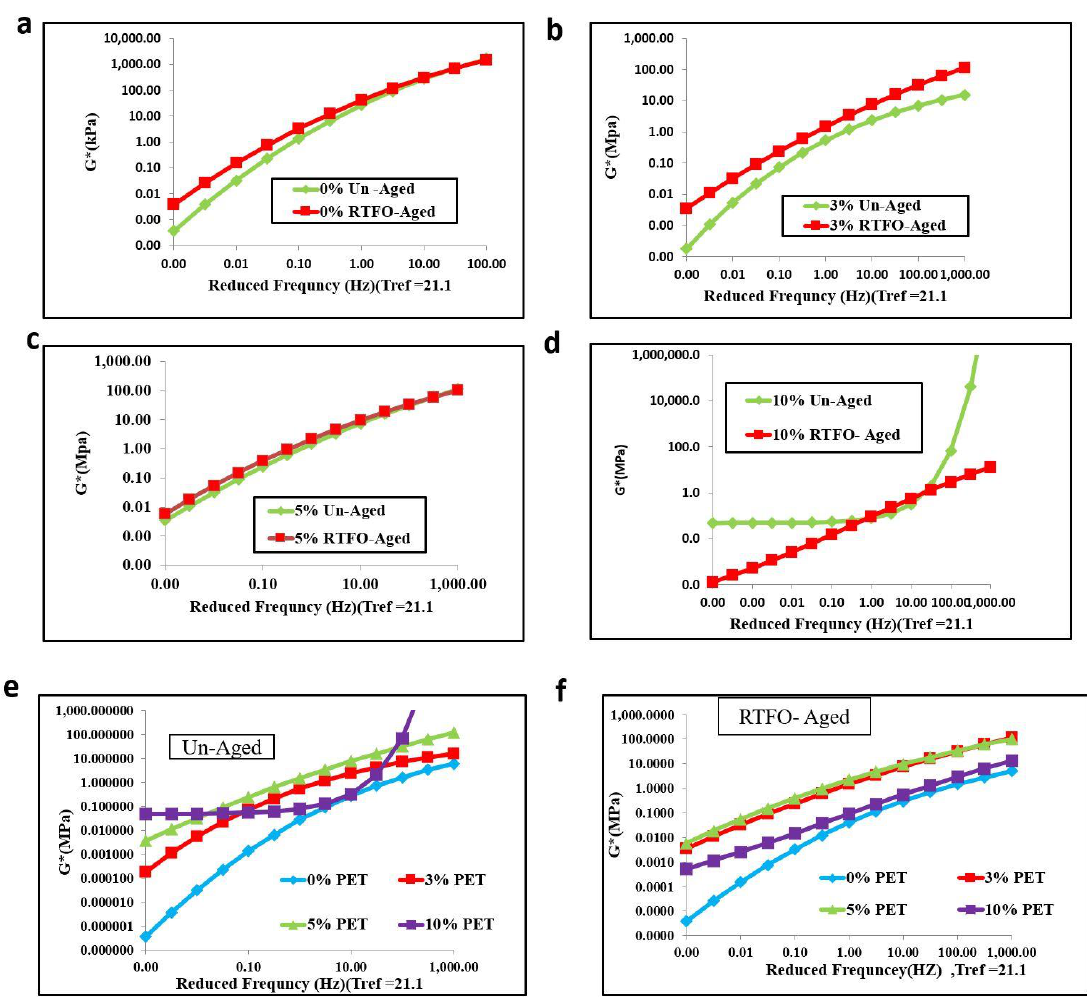
Figure 9. Master curve of complex modulus of unaged and RTFO-aged binder with PET content of ( a ) 0%, ( b ) 3%, ( c ) 5%, ( d ) 10%, ( e ) PET on unaged binder, and ( f ) PET on aged binder.